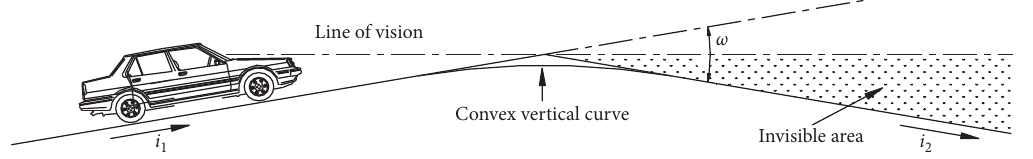
Figure 3: Convex vertical curve and change slope angle.